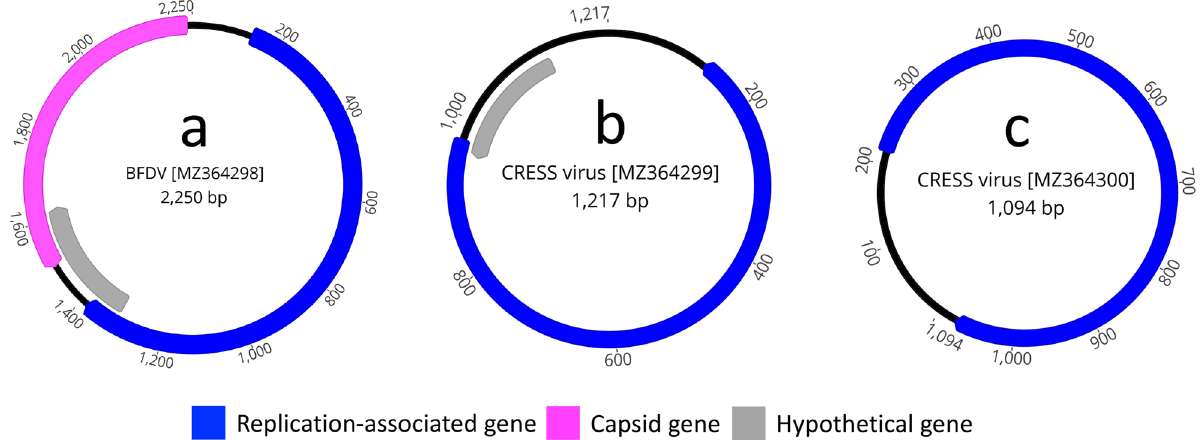
Figure 2. The whole genome sequence structure of circular viruses isolated from Neophema bird species. The arrows symbolise genes and open reading frames (ORFs), with orientation indicating their direction of transcription. Each gene or ORF is colour-coded, as indicated by the key in the